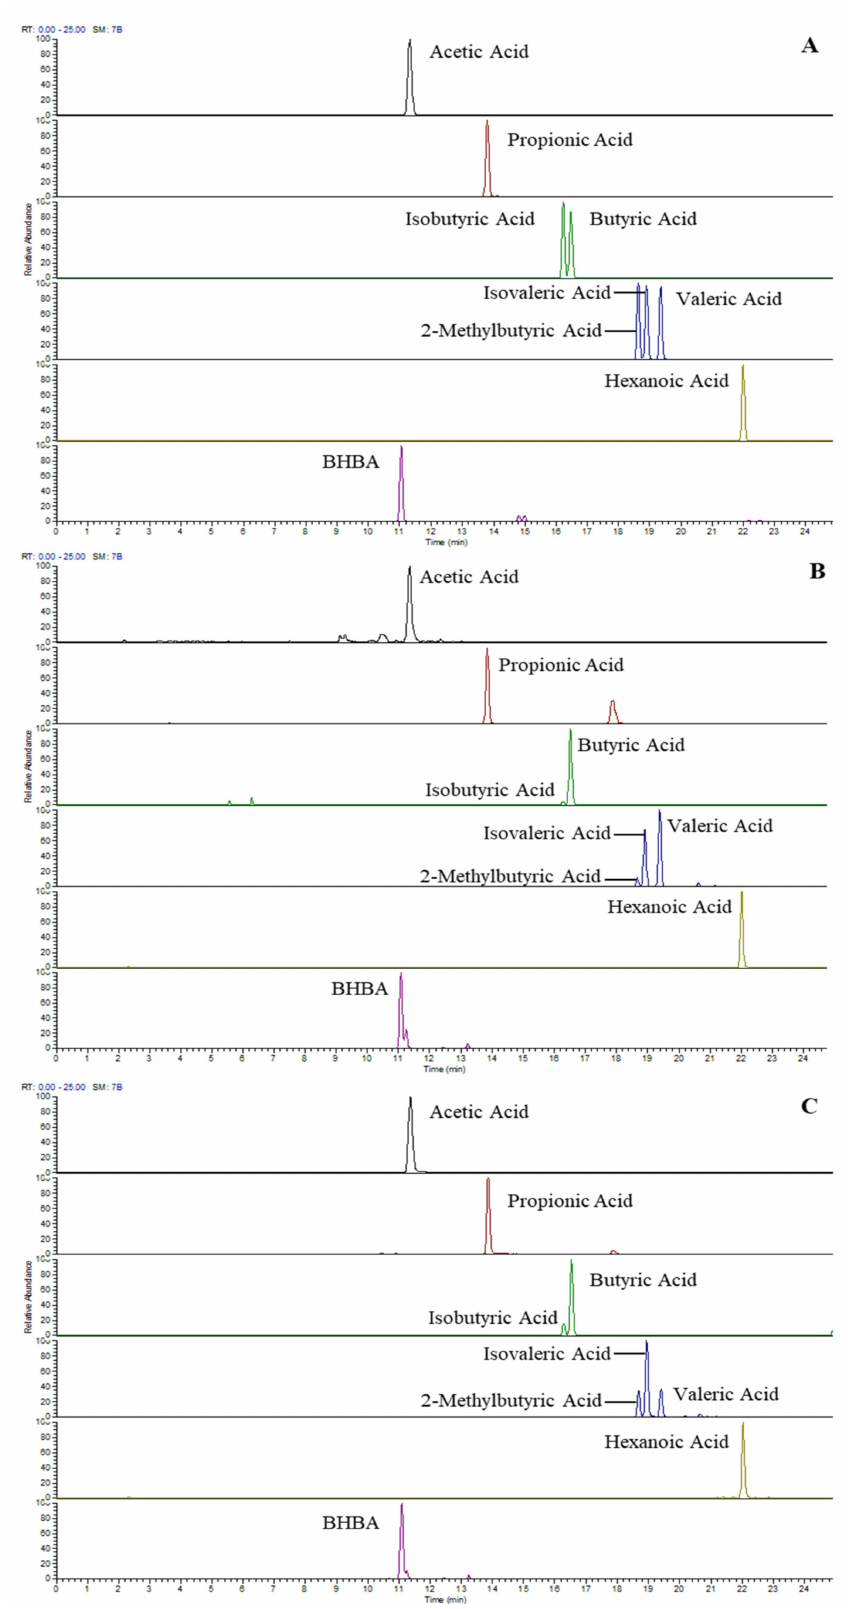
Figure 1. LC-MS profile (extracted ion chromatogram) of SCFA and BHBA acquired in positive ionisation mode from standards (3.3 µ g/mL each or 28~55 µ mol/L) ( A ), non-spiked raw milk ( B ) and non-spiked serum ( C